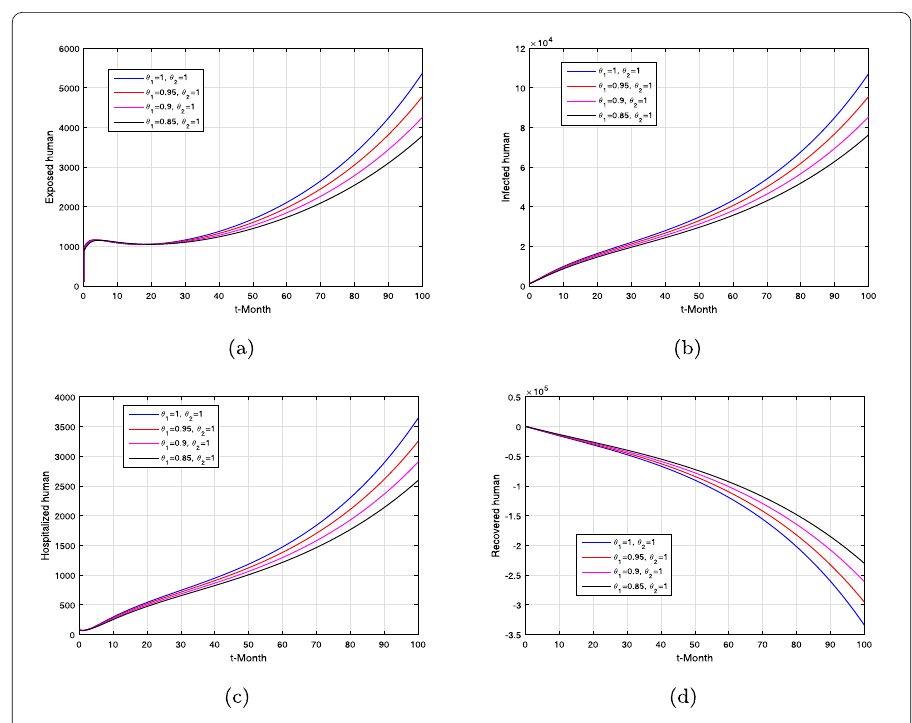
Figure 3 Simulation of the fractal-fractional model (10) when θ 1 = 1,0.95,0.9,0.85 and fractal order θ 2 = 1 where ( a ) exposed humans, ( b ) infected humans, ( c ) hospitalized humans, ( d ) recovered humans